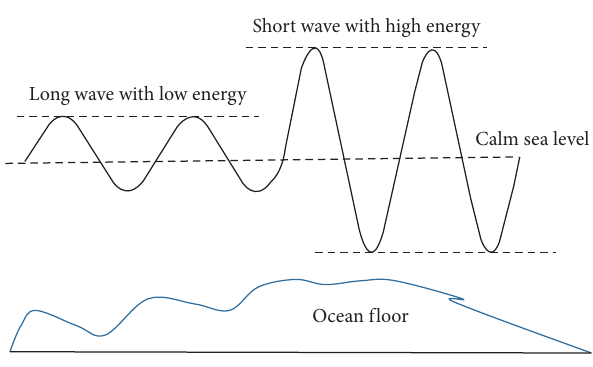
Figure 4: The details of